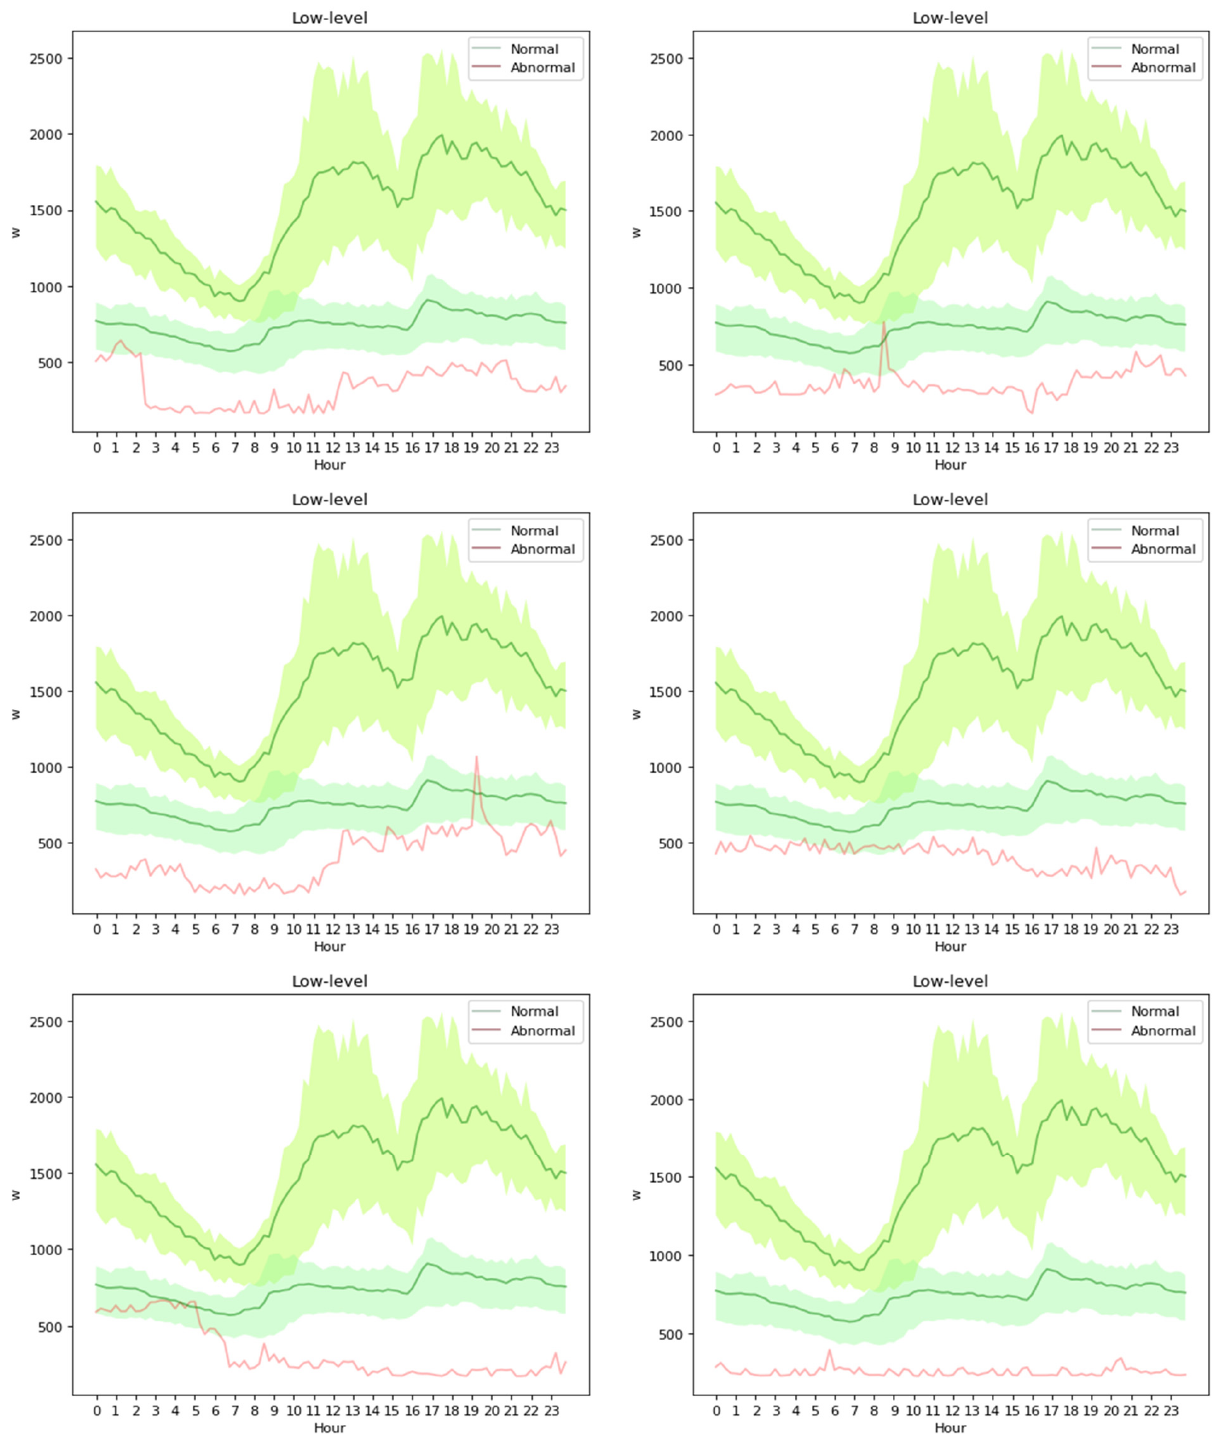
Figure A1. Load profiles of each abnormal electricity consumption events of User 01 using the low- level features.